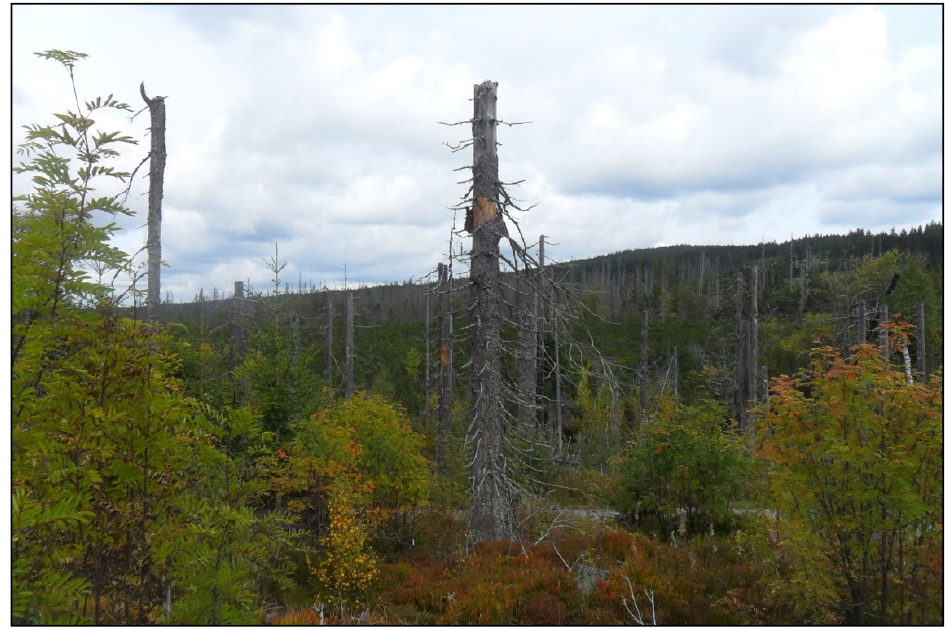
Figure 3. A forest affected by a bark beetle and wind disturbance in the Sumava NP (source: R. Hladky).